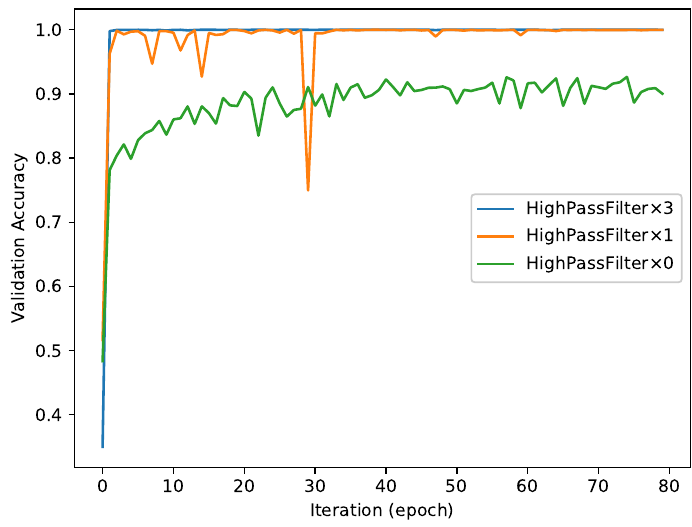
Figure 4. Validation performance of the proposed method.